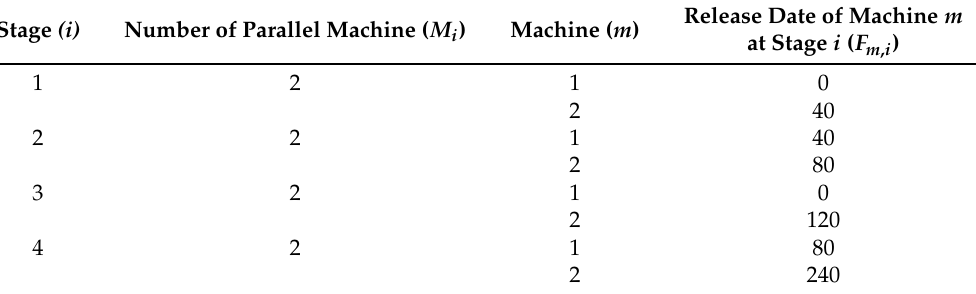
Table 3. A small example of case study consists of two machines and four stages. Stage (i) Number of Parallel Machine ( M i